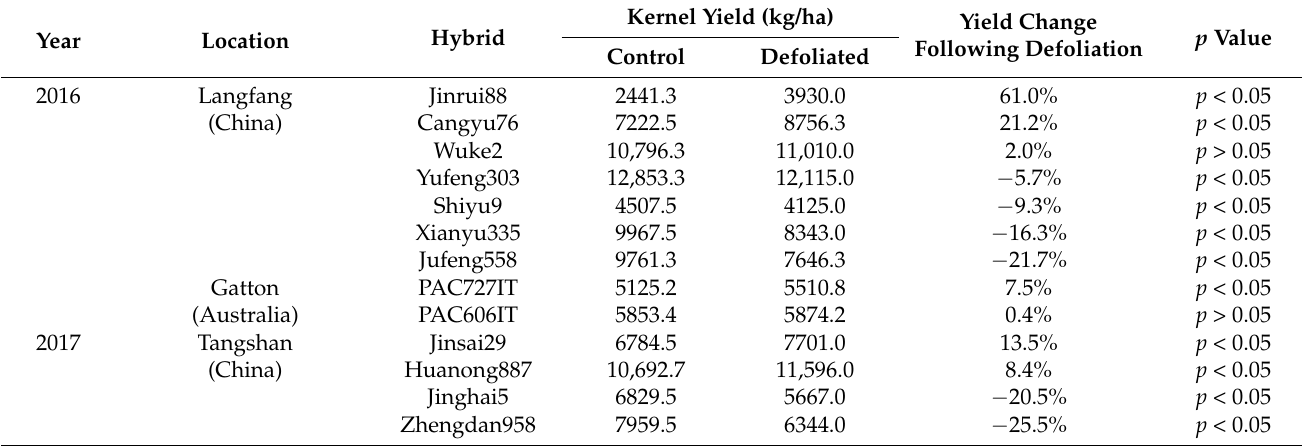
Table 1. Changes in kernel yields following defoliation in